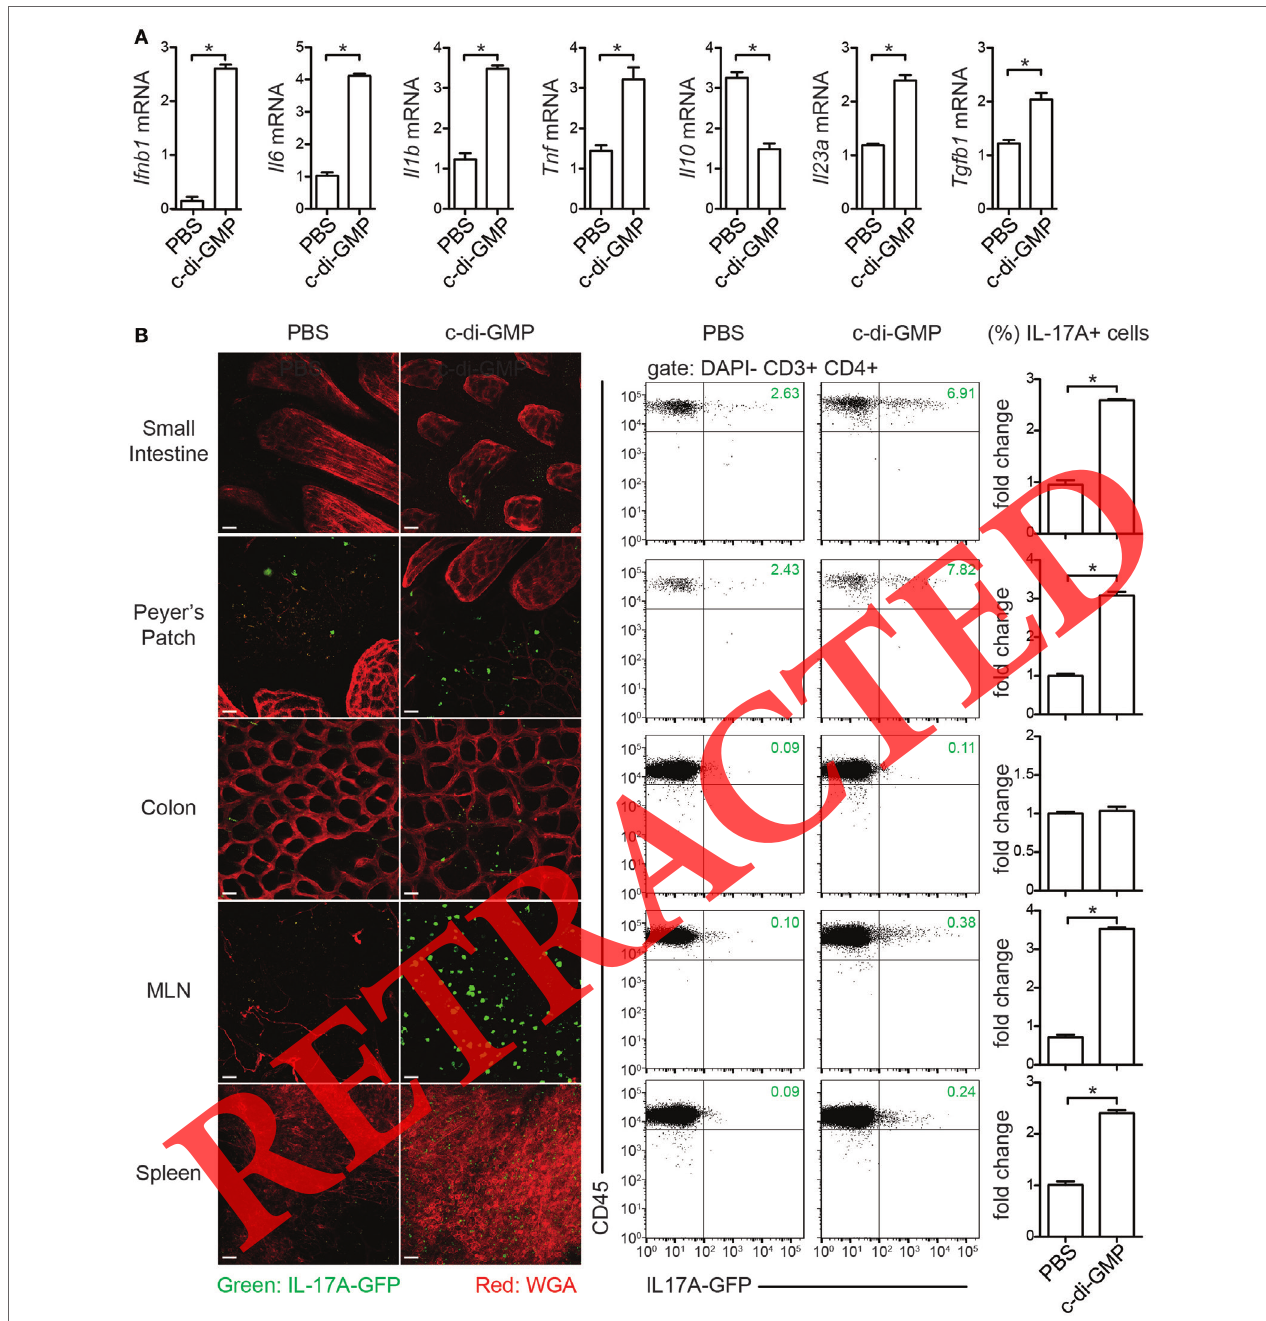
FigUre 2 | Stimulator of interferon genes (STING) triggers Th17 differentiation in gut. (a) Fold change of Ifnb1 , Il6 , Il1b , Tnf , Il10 , Il23a , and Tgfb1 gene expression in classical dendritic cells from small intestinal lamina propria in response to STING agonist. PBS or c-di-GMP was injected (i.p.) before sacrifice ( n = 5). (B) Confocal imaging (left) and flow cytometry analysis (middle) of IL-17A production together with IL-17A-expressing cells (right) in small intestine lamina propria, Peyer’s patch, colon, mesenteric lymph node and spleen in response to the activation of STING signaling. Il17a GFP/GFP reporter mice were injected (i.p.) with c-di-GMP on day − 5, day − 3, and day − 1, followed by wheat germ agglutinin (WGA) injected (i.v.) 7 min before sacrifice. Fold change was calculated according to flow cytometry analysis. Representative of three independent experiments ( n = 3). Scale bars, 50 µm.